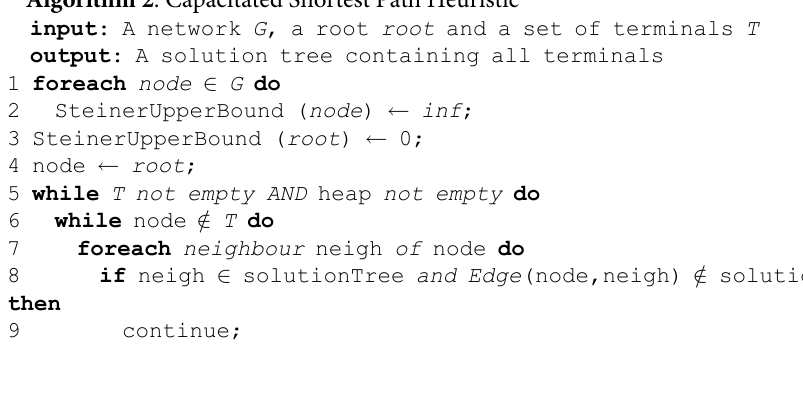
Algorithm 2 : Capacitated Shortest Path